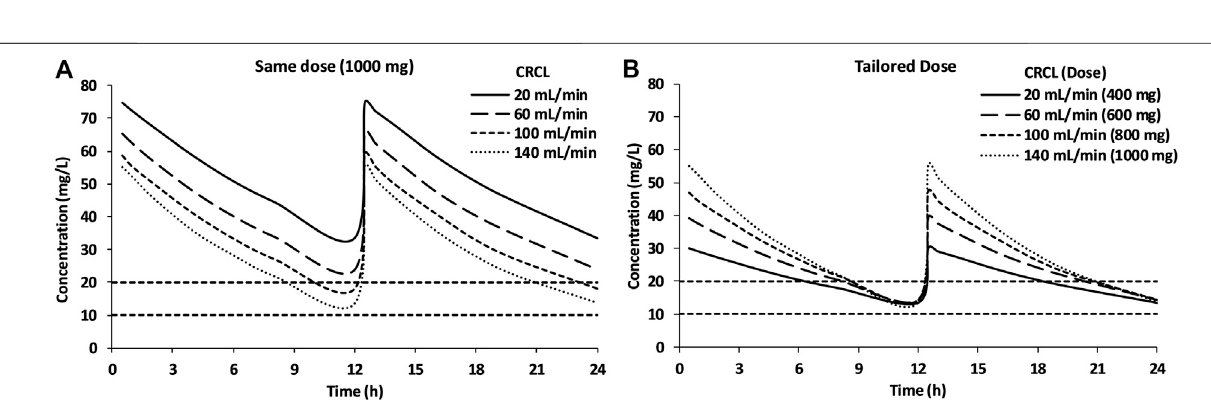
FIGURE 4 | Visual Predictive Checks of observed concentrations of vancomycin placed over the median, 5th and 95th percentiles of simulated concentrations.